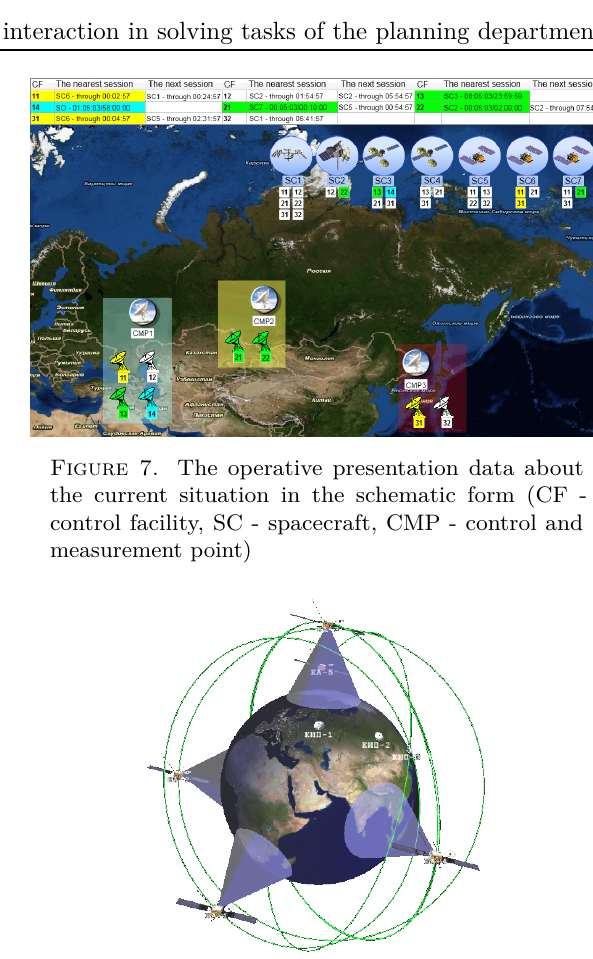
Figure 8. Example of visualization of data about state of spacecrafts